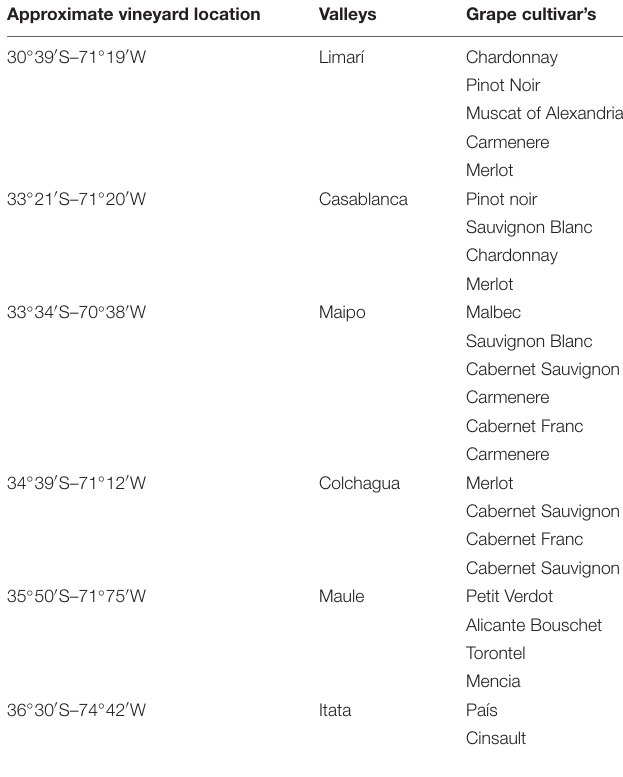
TABLE 1 | Vineyard locations and grape cultivars sampled. Approximate vineyard location